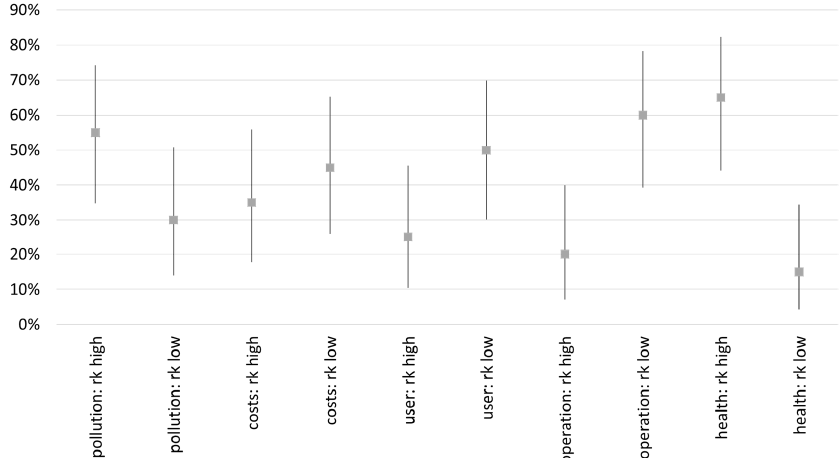
Figure 9. Preferences of local decision-makers based on the 2013 survey of politicians (20 data) about the importance of five criteria. High/low ranks denote the two highest/lowest ranks. Dots represent observed percentages and lines upper/lower one-sided 95% Clopper–Pearson confidence limits (Appendix, Equation (3)). Plot and computations using MS Excel.